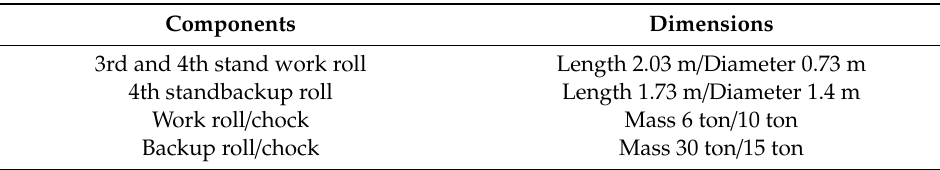
Figure 4. The model of F3 and F4 finishing mill stands incorporating a strip. Table 1. Dimensions and mass of rolls in finishing mill.